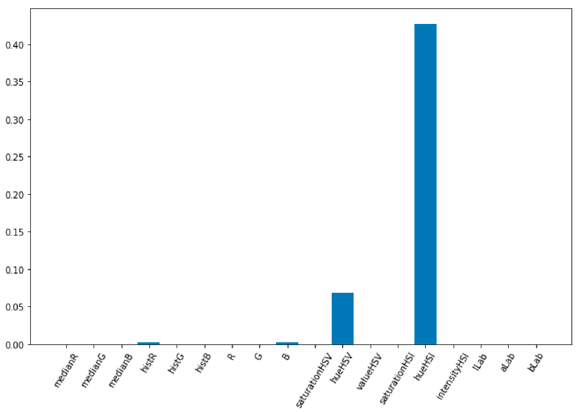
Figure 10. Feature importance graph for the Ensemble model generated by AutoML for tuna meat